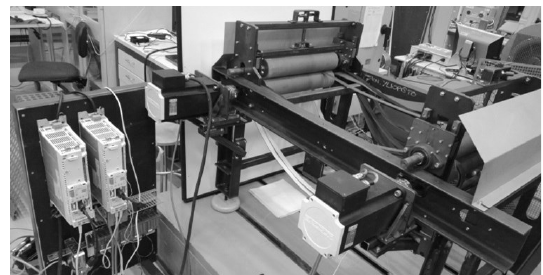
Figure 3: a) Experimental system applied in the labo- ratory measurements. Both of the rollers are driven by Baldor BSM100N-2250AD perma-